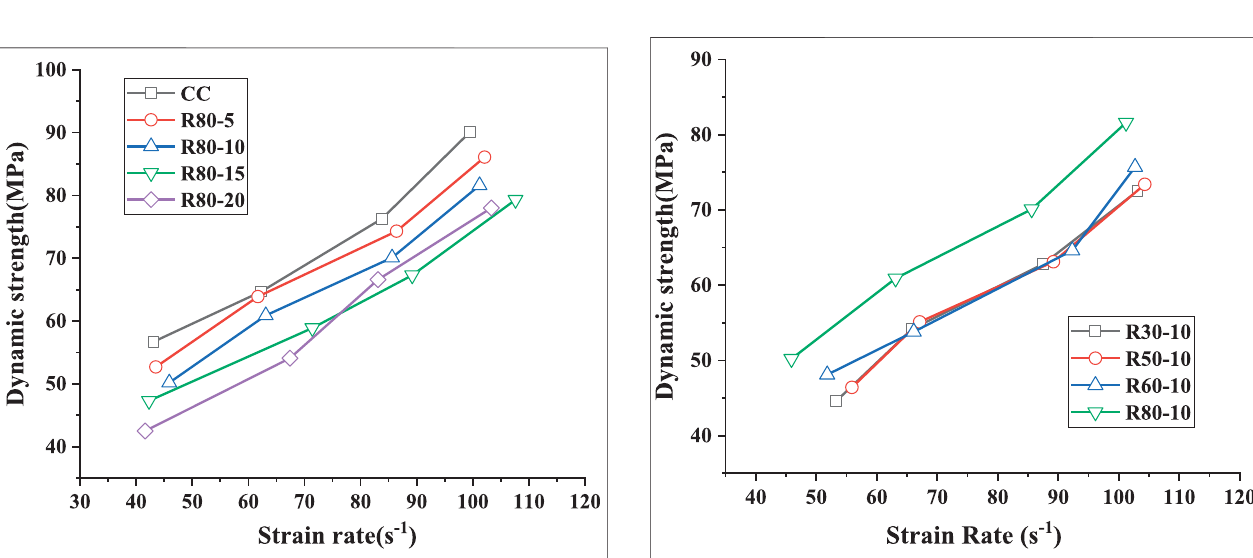
FIGURE 13 | Relationship between dynamic strength and strain rate of rubber mortar with different sizes of crumb